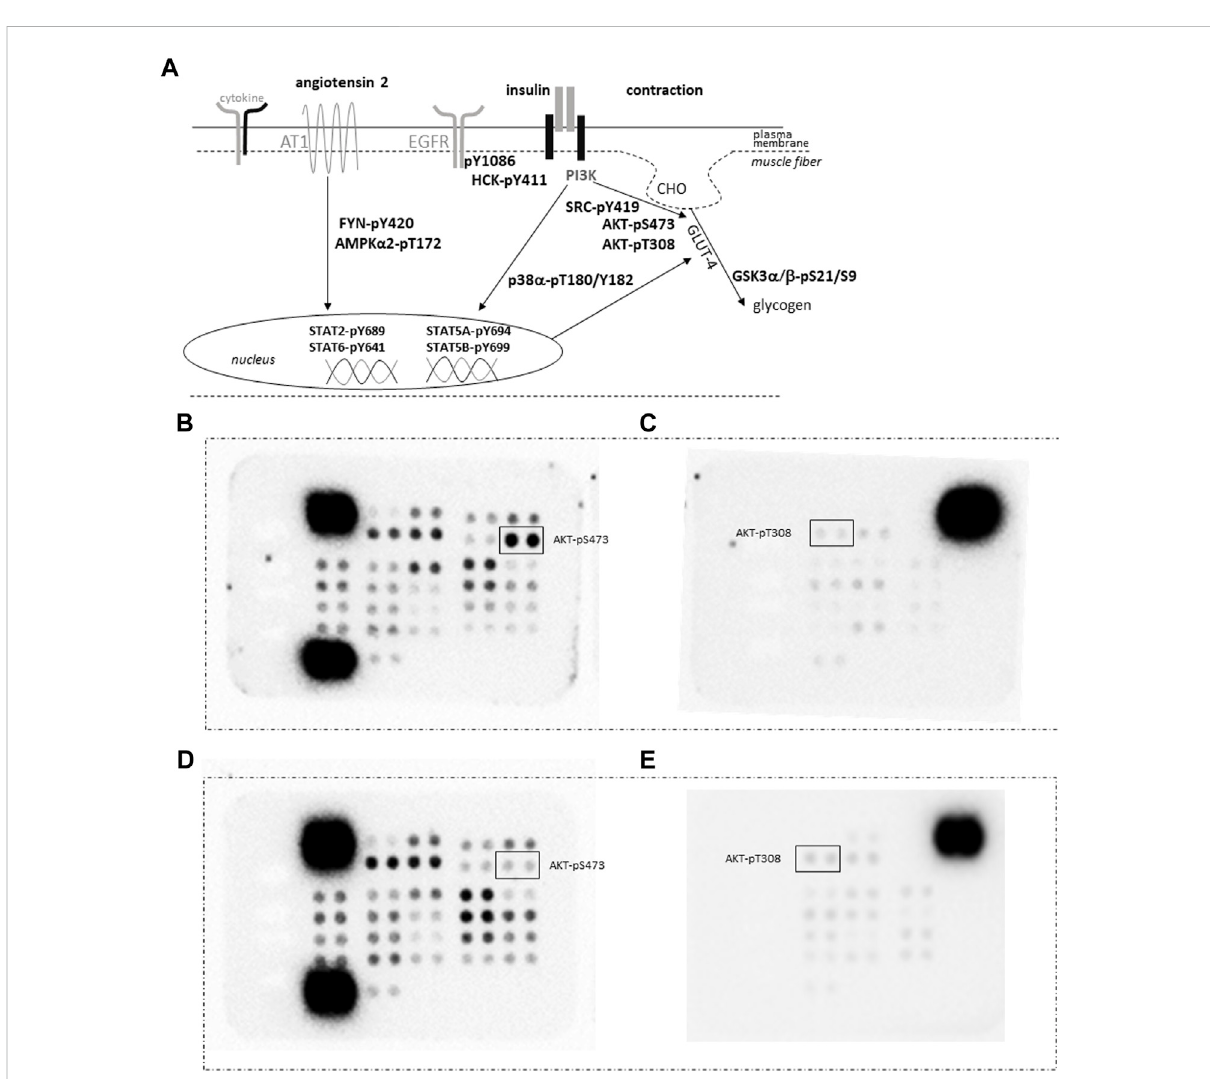
FIGURE 4 Quanti fi cationofproteinphosphorylation. (A) Sketchoftheassessedphosphorylationofsignaling proteins beinginvolvedinGLUT-4mediated glucose import as induced by contraction and insulin, angiotensin and cytokine signaling. Abbreviation: AT1, angiotensin receptor 1; CHO, glucose. (B – E) Images depicting the detection of the phosphorylation content for vastus lateralis muscle samples from an ACE-DD (B,C) and ACE-II (D,E) genotype ½hrs post exercise in pairs of fi ltersof thephospho-kinase arrays. Each phosphorylation content is assessed as measurement from a pairofspots. Thepositionofthespotpairsfor AKT-pS473 andAKT-pT308isindicated.Strongestsignals correspondto thereference signalsusedto ‘ standardize ’ the assessed